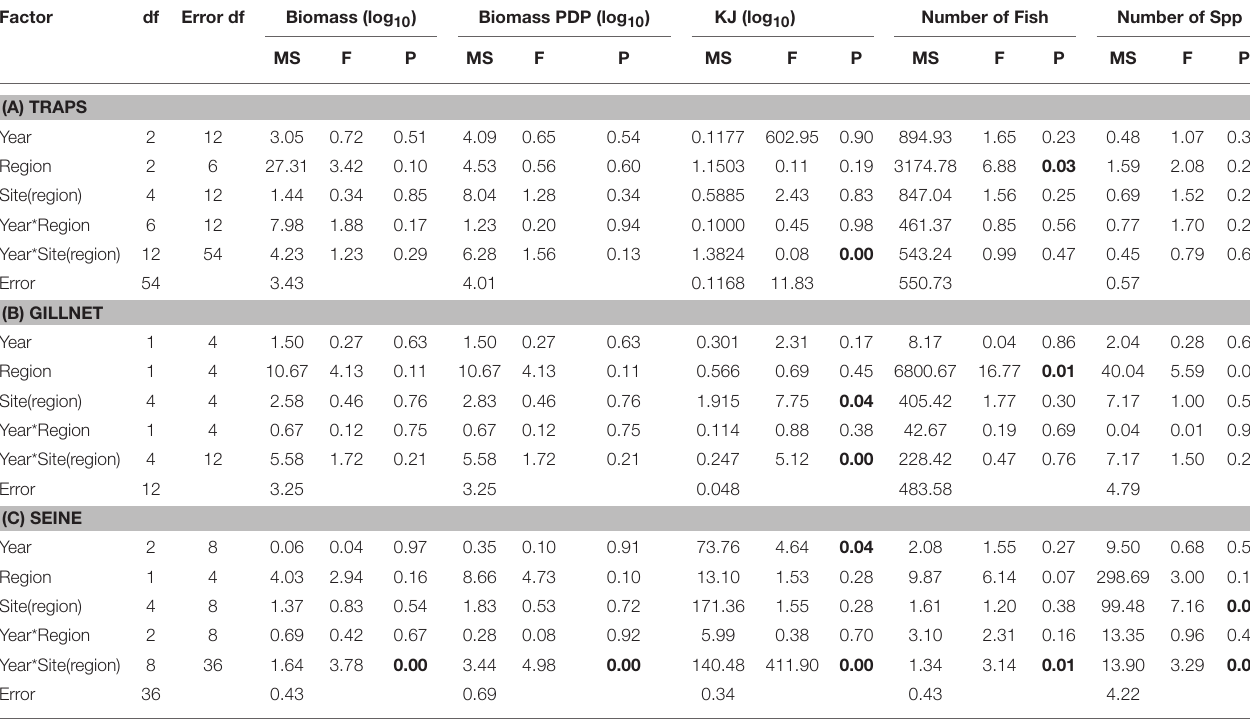
TABLE 7 | Summary of the results of nested ANOVAs to test for annual differences across summer seasons in the biomass, PDP biomass, KJ, number of fish, and number of species caught in (A) traps, (B) gillnets, and (C) seine nets between years and among regions and sites within region. Factor df Error